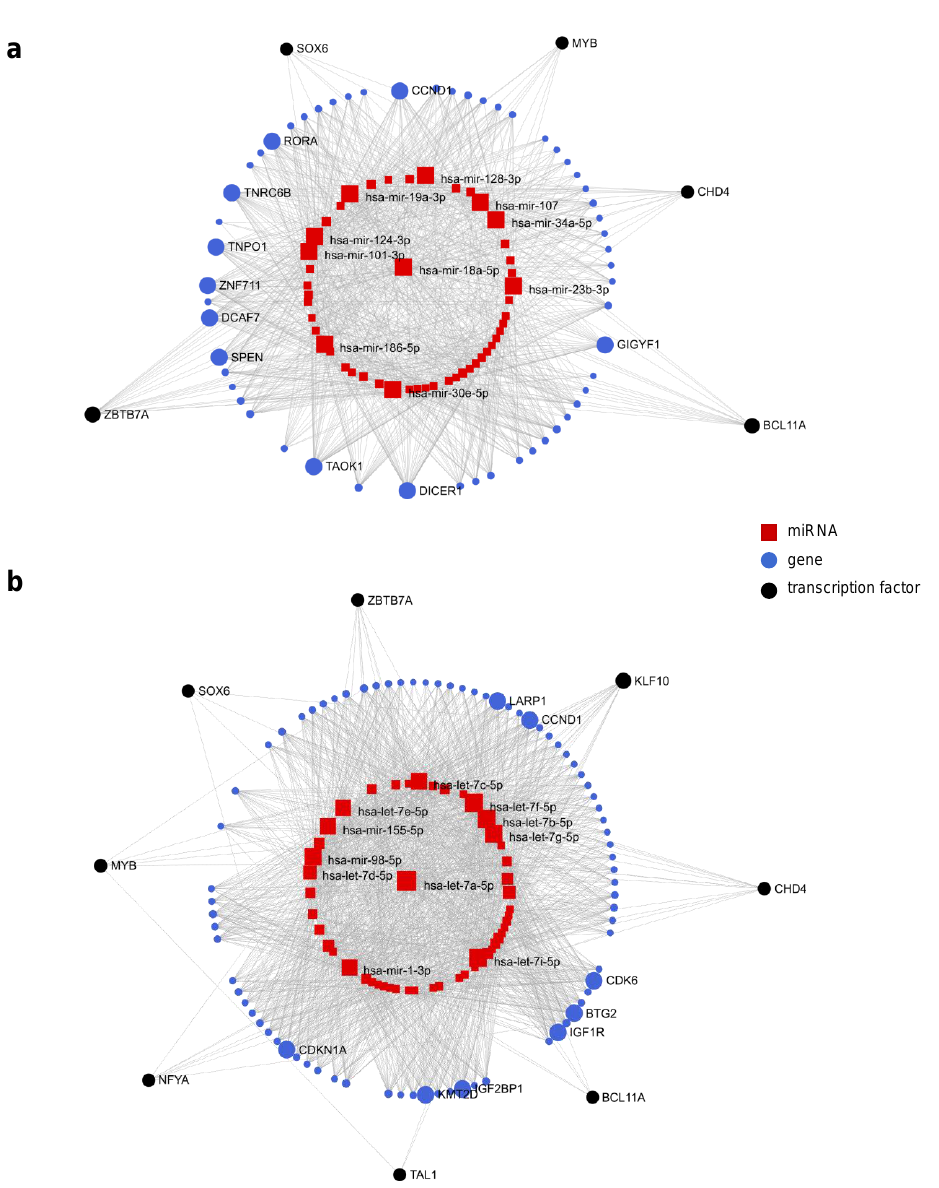
Figure 7. TF-miRNA co-regulatory networks illustrating the “multiple-to-multiple” pattern of miRNA interaction. Networks were extracted from miRNet using key erythroid transcription factors and DE miRNAs as input (accessed 12/2020). Analyses were performed in line with miRNet recommendations to limit network size (<2000 nodes), i.e., the “Data Filter” function was used, based on the network topology measures—degreed, betweenness, and shortest path. In this context, the degree of a node is the total number of connections it has to other nodes, and high-degree nodes are considered important “hubs” in a network (set to the default 1.0 here). The betweenness measures the number of shortest paths going through a node, and nodes with higher betweenness are important interactors in a network (set to 1.0 here). The shortest path filter helps reduce the complexity of a network by keeping only one, the shortest, path between hub nodes, i.e., in the presence of multiple paths connecting two nodes, only the shortest path will be retained (applied here). In the figure, node size indicates betweenness centrality, with large symbols highlighting hub nodes. The components shown are (from inside out) input miRNAs mapped to a network, miRNet-identified target genes, and input TFs mapped to a network, as indicated with corresponding symbols. ( a ) TF-miRNA co-regulatory network of known miRNAs upregulated in HUDEP1_L. ( b ) TF-miRNA co-regulatory network of known miRNAs upregulated in